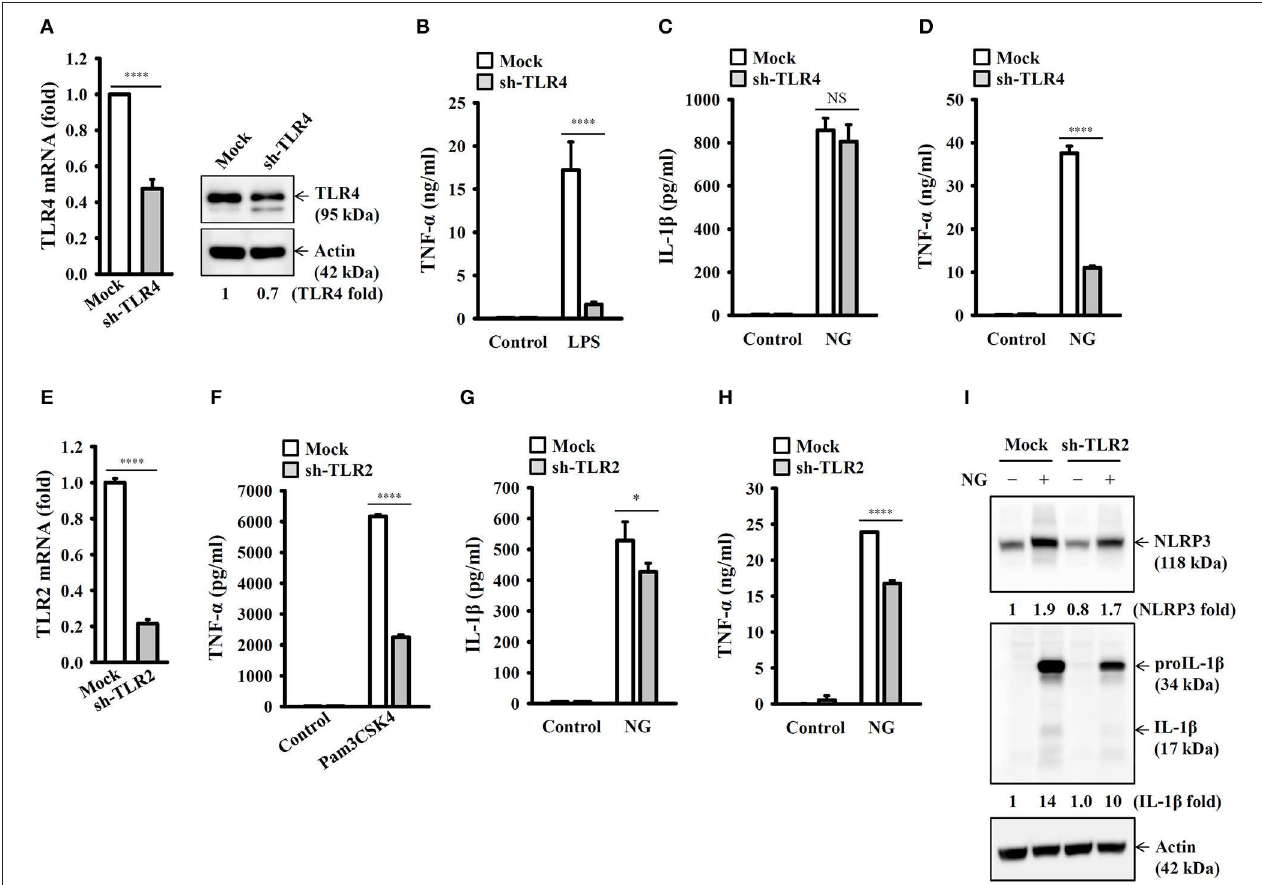
FIGURE 3 | Priming of the NLRP3 inflammasome by live NG through TLR2. (A) The mRNA and protein expression levels of TLR4 in wild-type (mock) or TLR4-knockdown (sh-TLR4) J774A.1 macrophages were measured by RT real-time PCR and Western blotting, respectively. (B) Mock or sh-TLR4 cells were incubated for 6h with 1 µ g/ml LPS. The levels of TNF- α in the supernatants were measured by ELISA. (C,D) Mock or sh-TLR4 cells were infected for 24h with NG at 50 MOI. The levels of IL-1 β (C) and TNF- α (D) in the supernatants were measured by ELISA. (E) The mRNA expression levels of TLR2 in mock or TLR2-knockdown (sh-TLR2) J774A.1 macrophages were measured by RT real-time PCR. (F) Mock or sh-TLR2 cells were incubated for 6h with 1 µ g/ml Pam3CSK4. The levels of TNF- α in the supernatants were measured by ELISA. (G–I) Mock or sh-TLR2 cells were infected for 24h (G,H) or 8h (I) with NG at 50 MOI. The levels of IL-1 β and TNF- α in the supernatants were measured by ELISA (G,H) , and the levels of NLRP3 and proIL-1 β /IL-1 β in the cell lysates were measured by Western blotting (I) . The RT real-time PCR and ELISA data are expressed as the mean ± SD of three separate experiments. The bands intensity of Western blotting was analyzed by ImageJ and expressed as the fold change compared with the mock control group normalized to actin. A significant difference at the level of * p < 0.05 and **** p < 0.0001. NS, not significant (two-tailed t -test).